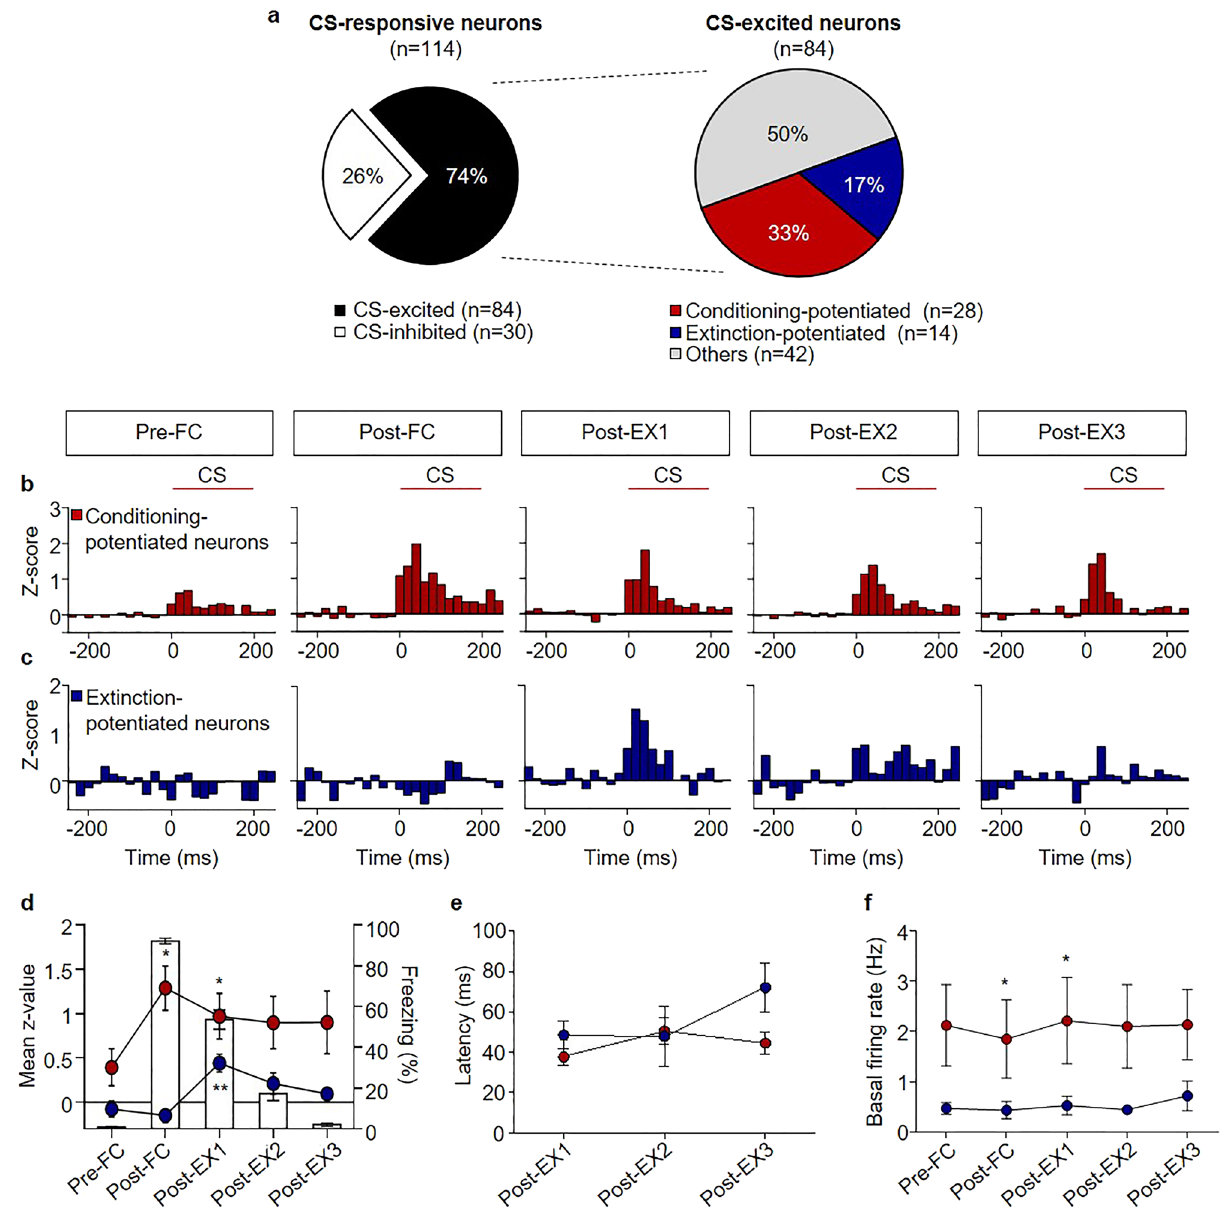
Figure 3. Conditioning-potentiated and extinction-potentiated neurons display potentiated responses to the CS after conditioning and extinction, respectively. ( a ) Pie chart showing the percentage of CS-excited neurons among the CS-responsive neurons (left) and the percentage of conditioning-potentiated and extinction- potentiated neurons among the CS-excited neurons (right). ( b ) Z-score PETH of conditioning-potentiated neurons (n = 28, 33% of CS-excited neurons). ( c ) Z-score PETH of extinction-potentiated neurons (n = 14, 17% of CS-excited neurons). ( d ) Averaged time courses of freezing responses and neuronal activity (z-scores) of conditioning-potentiated (red circle) and extinction-potentiated neurons (blue circle). Each bar represents the averaged freezing during five consecutive CS presentations, and each point represents the averaged z-scores during five consecutive CS presentations. ( e ) Comparison of the onset response across all behavioral sessions. ( f ) Comparison of the basal firing rates of the conditioning-potentiated and extinction-potentiated neurons across all behavioral sessions. * p < 0.05; ** p <